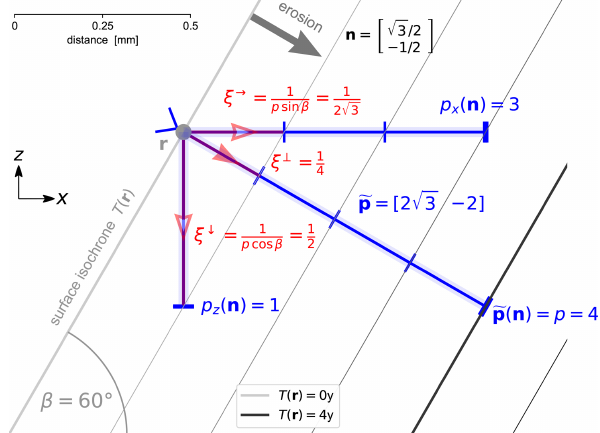
Figure 3. Tracking surface motion at a point r using a slow- ness covector (cid:101) p normal to the erosion front T ( r ) that points in the direction n . Normal slowness here is p = (cid:101) p ( n ) = 4yrmm − 1 (Eqs. 13 and 18) for a surface tilted at β = 60 ◦ corresponding to a surface-normal erosion rate of ξ ⊥ = 1 / 4mmyr − 1 (Eq. 8). Simple trigonometry applied to p gives the vertical and horizontal slow- nesses (Eq. 17), and their reciprocals are the vertical ξ ↓ and hori- zontal ξ → erosion rates (Eqs. 9, 10, and 17). The front covector is also the gradient of the arrival times, or isochrone density, given by (cid:101) p = ∇ T , which counts the number of isochrones crossed in unit time in the front-normal direction (Eq.